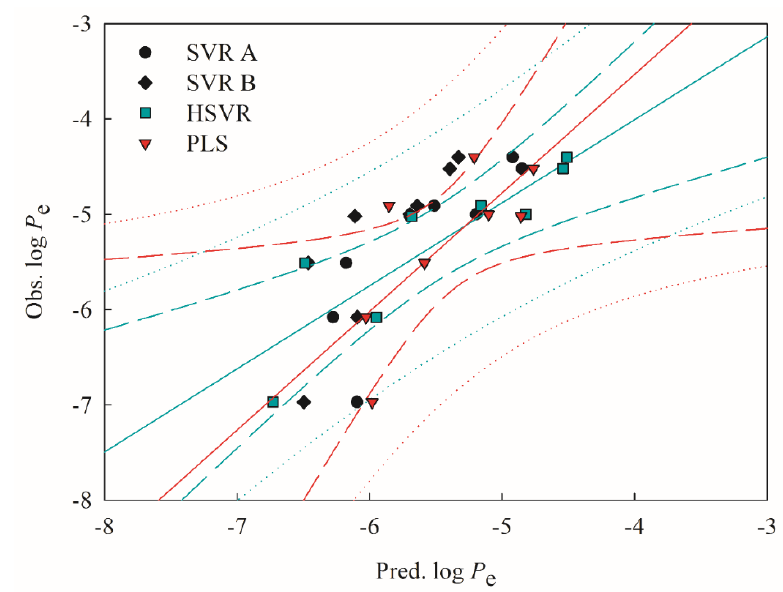
Figure 5. Observed log P e vs. the log P e predicted by SVR A (solid circle), SVR B (solid diamond), HSVR (green square), and PLS (red triangle) for the molecules in the outlier set. The green and red solid lines, dashed lines, and dotted lines correspond to the HSVR and PLS regressions of the data, 95% confidence intervals for the HSVR and PLS regressions, and 95% confidence intervals for the prediction, respectively.